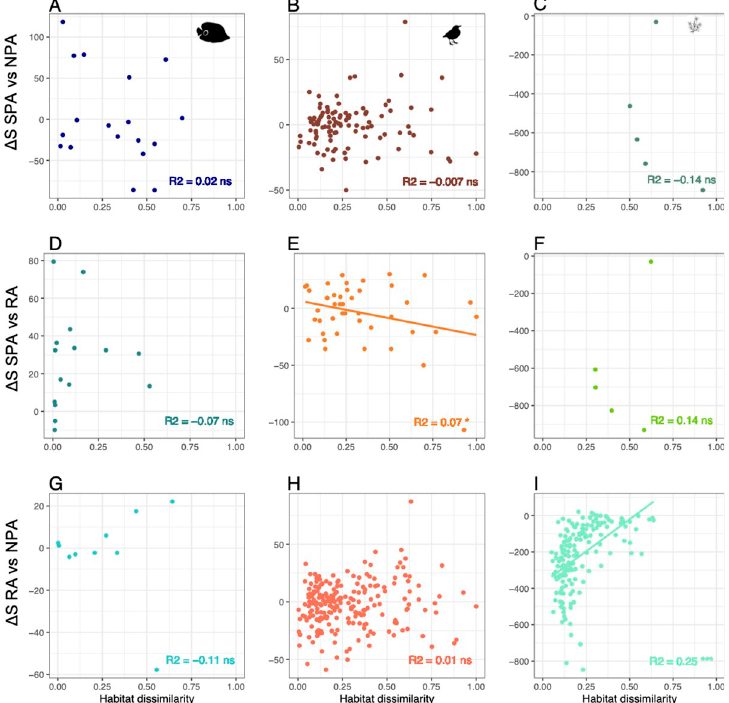
Fig 4. Linear relationships between environmental dissimilarity and the difference in species richness ( Δ S) for reef fishes ( A, D, G ), birds ( B, E, H ), and alpine plants ( C, F, I ) for pairwise comparisons between SPA, RA, and NPA across regions in a buffer of 50 km (each dot is a protected area). ��� p -value < 0.001, �� p -value < 0.01, � p - value < 0.05. The raw data can be found in https://github.com/LoiseauN/Betadiversity-protected-areas. NPA AU : AnabbreviationlisthasbeencompiledforthoseusedinFig 4 : Pleaseverifythatallentriesarecorrect : Inaddition ; pleasedefine � ns � inFig 4 abbreviationlistifthisindeedisanabbreviation : , Non- Protected Areas; ns, non significant; RA, Restricted Areas; SPA, Strictly Protected